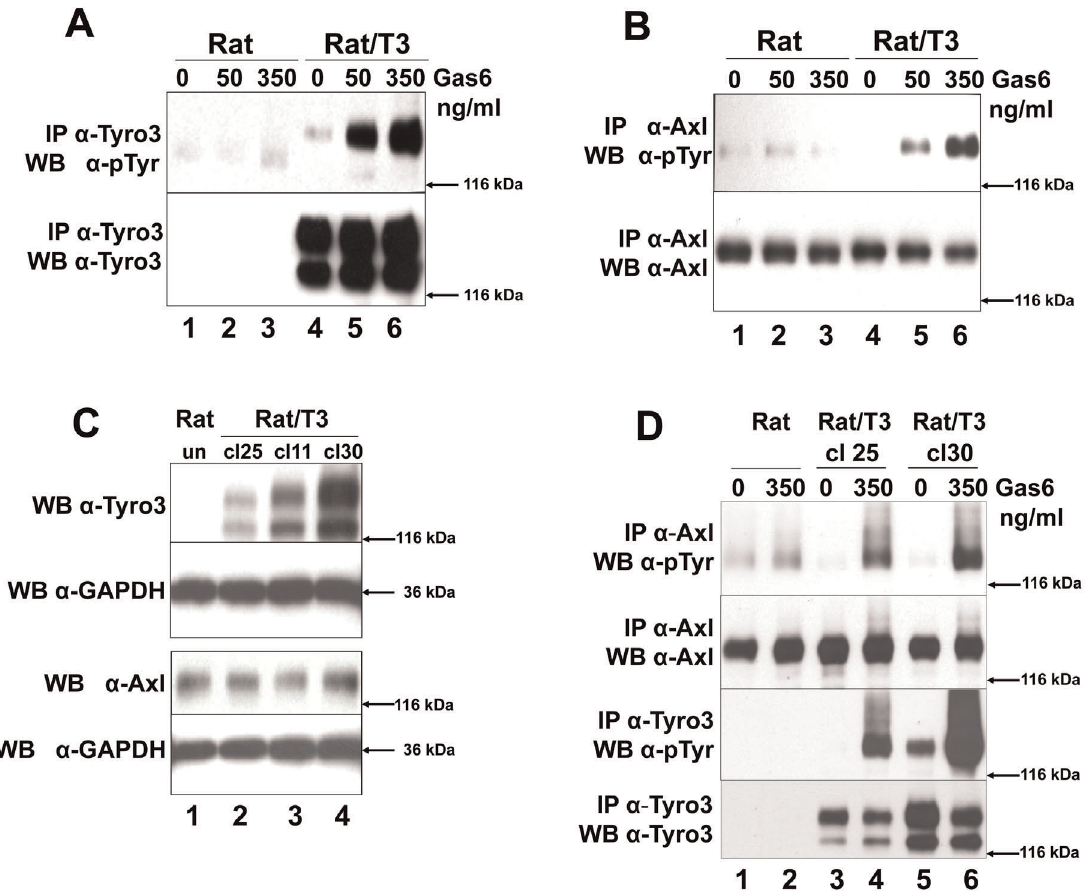
Figure 4. Tyro3 increases Gas6-induced Axl phosphorylation. Rat2 (Rat lanes 1–3) and Rat2/T3V5 cells (Rat/T3, lanes 4–6) were treated with 0, 50, 350 ng/ml Gas6 for 20 min. Detergent cell lysates were prepared and normalized for protein concentration. The samples were divided in two for Tyro3 (panel A) and Axl (panel B) immunoprecipitations (IP). This was followed by SDS-PAGE using 8% gels followed and Western blot analysis. The membranes were probed with anti-phosphotyrosine ( a -pTyr) antibodies (PY20 and P99 mixture 1:3,500) (top, panels A and B). The membranes were stripped and reprobed with a -Tyro3 serum 5424 (1:3,500) (A, bottom panel) or affinity purified rabbit a -Axl (1:3,500) (B, bottom panel). These blots are representative of 4 experiments. To determine whether Tyro3 expression affects Axl levels in Rat2 cells (panel C), detergent cell extracts were prepared from Rat2 cells (lane 1) , and independently derived stably transfected Rat2/T3V5 cell lines (clone (cl) 25, lane 2; clone 11, lane 3; clone 30, lane 4) . SDS-PAGE using 4–20% gels followed by Western blot analysis was performed on these extracts. The membranes were cut at the level of the 66 kDa marker and the top portion was probed with rabbit a -Tyro3 (5424 serum 1:3,500) or rabbit a -Axl (1:3,500). The bottom portion of the membranes were blotted with a -GAPDH (1:500) . These blots are representative of 5 experiments. To determine if the levels of Axl phosphorylation depended on the levels of Tyro3 expressed (panel D) Rat2 cells (lanes 1 and 2) and Rat2/T3V5 cell lines cl25 (lanes 3 and 4) and cl30 (lanes 5 and 6) were activated with media only (0) or 350 ng/ml of Gas6 for 10 min. Detergent cell lysates were prepared and normalized for protein concentration. The samples were divided in two for Tyro3 and Axl immunoprecipitations (IP). SDS-PAGE using 8% gels followed by Western blot analysis was performed. The membranes were probed with anti-phosphotyrosine ( a -pTyr) antibodies (PY20 and P99 mixture 1:3,500) (top and third panels). An aliquot of the remaining Axl IPs were reloaded and probed with affinity purified rabbit a -Axl (1:3,500) (second panel from the top) . The membrane corresponding to Tyro3 IP’s was stripped and reprobed with a -Tyro3 serum 5424 (1:3,500) (bottom panel) . These blots are representative of 6 experiments. doi:10.1371/journal.pone.0036800.g004 were blotted against Tyro3 we also were able to detect it as ylation (lane 5) when compared to those expressing lower levels of demostratedbytnhepresenceofitssignaturedoublet(Fig.5Dlane2). Axl (lane 2). These results indicated that Tyro3 can be crosss- Given that the antibodies used against Tyro3 and Axl are specific for phosphorylated by Axl since the kdTyro3 lacks kinase activity. We eachofthereceptors(seeFig.1)theseexperimentssuggestthatTyro3 then tested whether Tyro3 and Axl co-precipitated as an and Axl closely interact. indication that the two receptors closely interact. When Tyro3 immunoprecipitates were blotted with anti-Tyro3 (Fig. 5D lanes 1) monomeric forms of the approximately 125– 120 kDa doublet characteristic of Tyro3 were detected. When the Tyro3immunoprecipitateswereblottedagainstAxl,wealsodetected monomericAxl(Fig.5Dlane3).WhenAxlimmunoprecipitateswere blotted against Axl we detected bands corresponding to monomeric Axlasexpected(Fig.5Dlane4).WhentheseAxlimmunoprecipitates